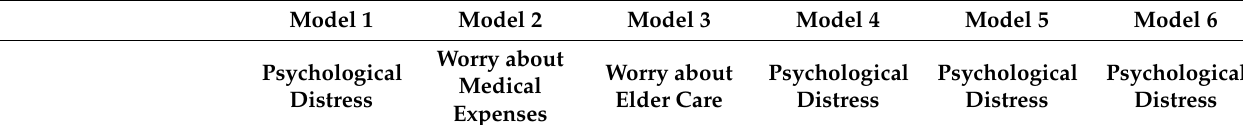
Table 4. Three-level mixed-effects models on psychological distress and